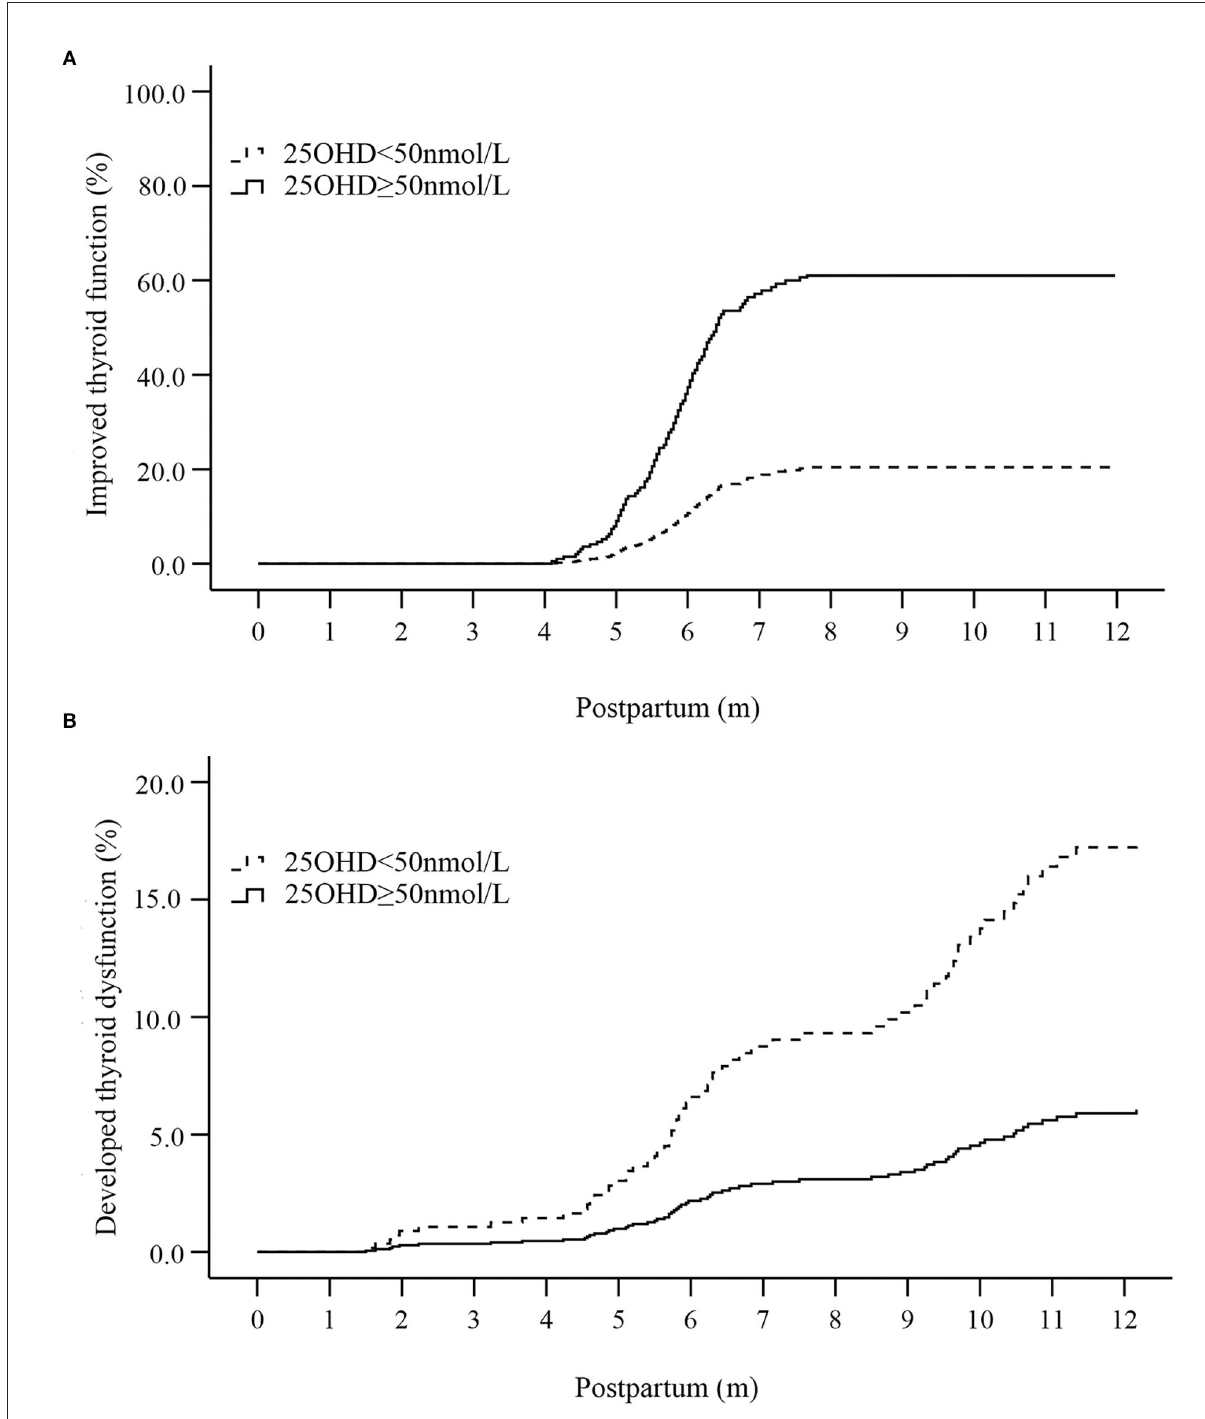
FIGURE2 Curves of postpartum thyroid function affected by the vitamin D status in the first trimester [ (A) the curve of improved thyroid function; (B) the curve of developed thyroid dysfunction]. 25OHD, 25-hydroxyvitamin D.